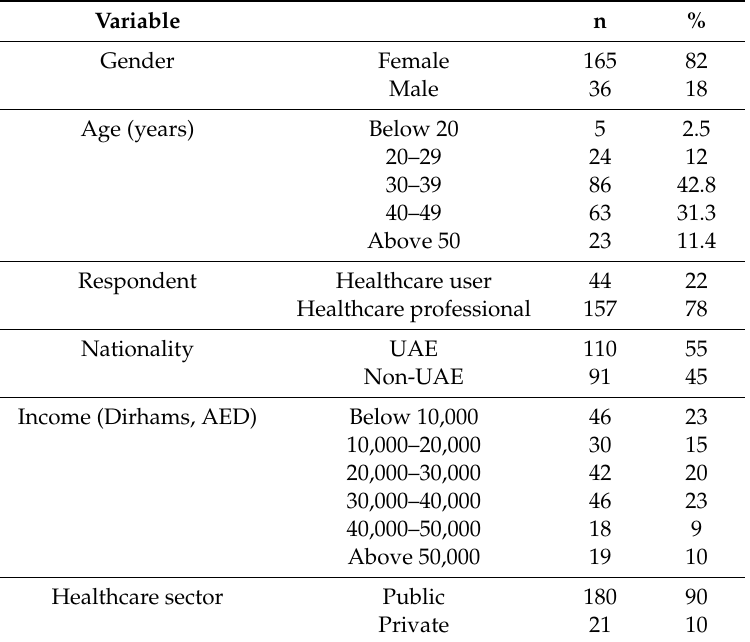
Table 1. The demographic characteristics of the